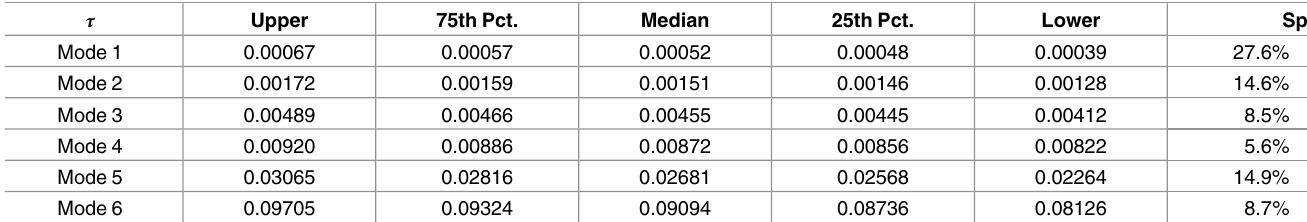
We investigate the biological meaning of our dynamic modes by calculating their projec- tions onto the PLM modes. This reveals that two of the six dynamic modes correspond to pre- viously-discovered PLM modes. These projection values quantify the similarity between the spatial patterns of the previously-discovered, physiologically meaningful PLM modes and the DMD modes which we inferred from our random impulse trials. Fig 4 shows the magnitude of each dynamic mode’s projection onto the displacement mode and PLM plane. Corresponding numerical values are given in Tables 1, 2 and 3. We compare these against the projections of 1,000 random modes. Both the displacement mode and the PLM Plane have a single dynamic mode projecting strongly onto them. Therefore the low-dimensional structure of the fixed point facilitates responses in both the displacement mode and PLM Plane directions, with a highly distinct timescale for each response. Mode 4, which projects strongly onto the displacement mode, is particularly interesting. It has the most consistent timescale between trials (see Table 1). Additionally, all other dynamic modes have a particularly low projection onto the displacement mode (i.e. a significantly lower median projection than random modes). This suggests that the low-dimensional structure of the fixed point facilitates responses in that direction with a particularly consistent timescale.